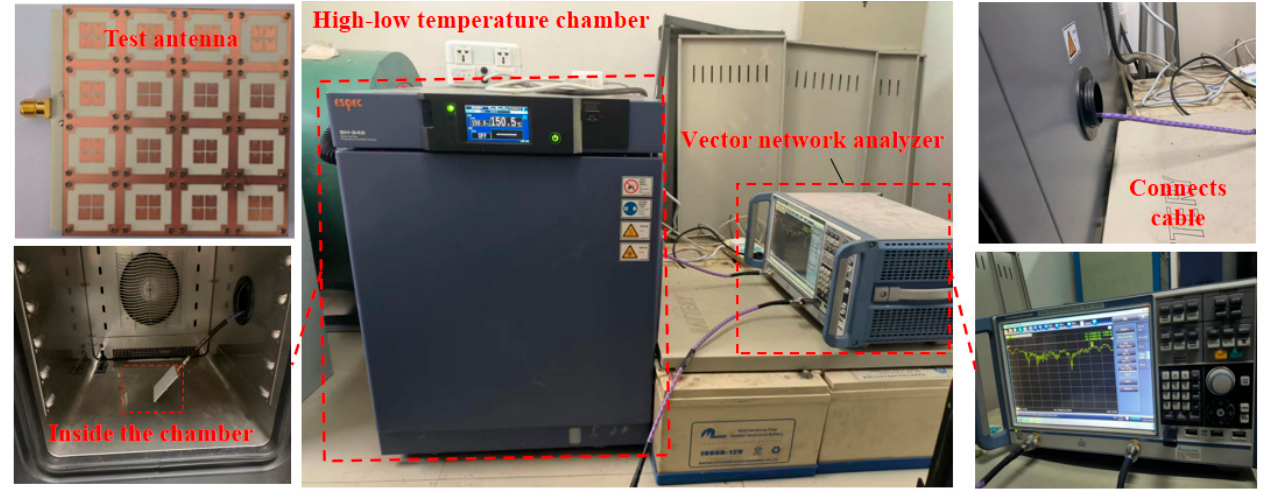
Figure 16. Measurement setup in the high–low temperature chamber.